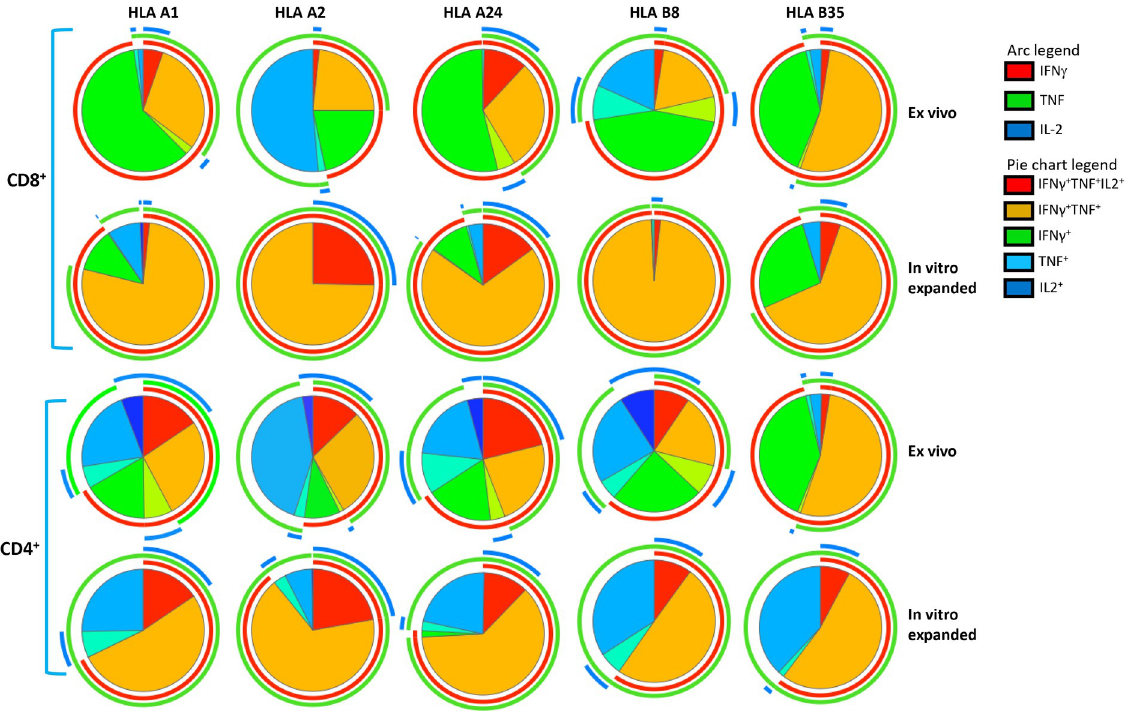
Fig 4. CMV vaccine induces polyfunctional CMV-specific CD8 + and CD4 + T cells: In vitro expanded CMV-specific T cells from HLA expressing immunized mice were assessed for polyfunctional profile using multiparametric intracellular cytokine assay. These T cells were assessed for the expression of IFN γ , TNF and/or IL-2 simultaneously by flow cytometry in combination with SPICE software. Pie charts represent the proportion of CMV-specific CD8 + and CD4 + T cells expressing various combinations of IFN γ , TNF and/or IL2 cytokines after ex vivo and in vitro expansion. Arc indicates the proportion of CMV-specific CD8 + and CD4 + T cells expressing individual cytokines (IFN γ , TNF or IL-2).